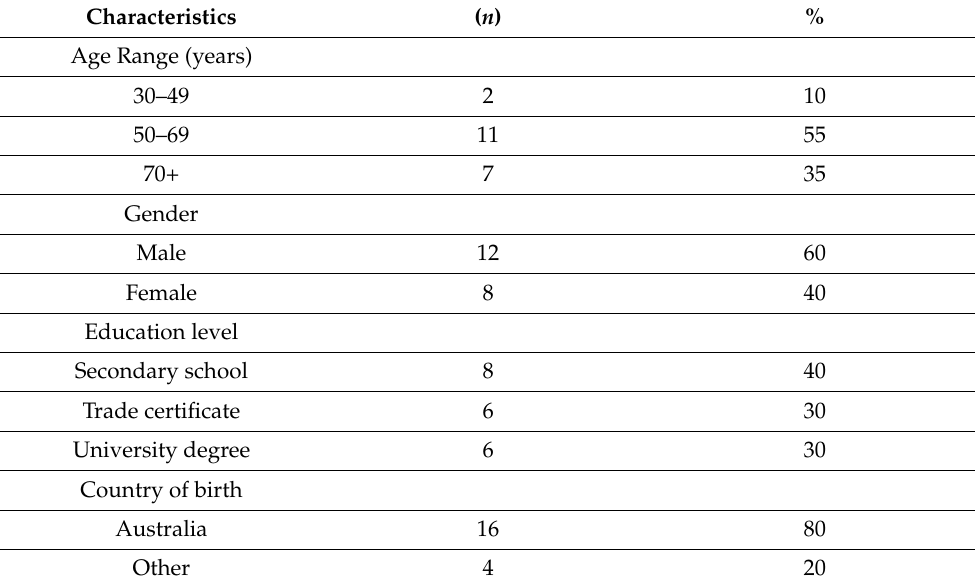
Table 1. Demographic information of participants who participated in both tests of the survey ( n =